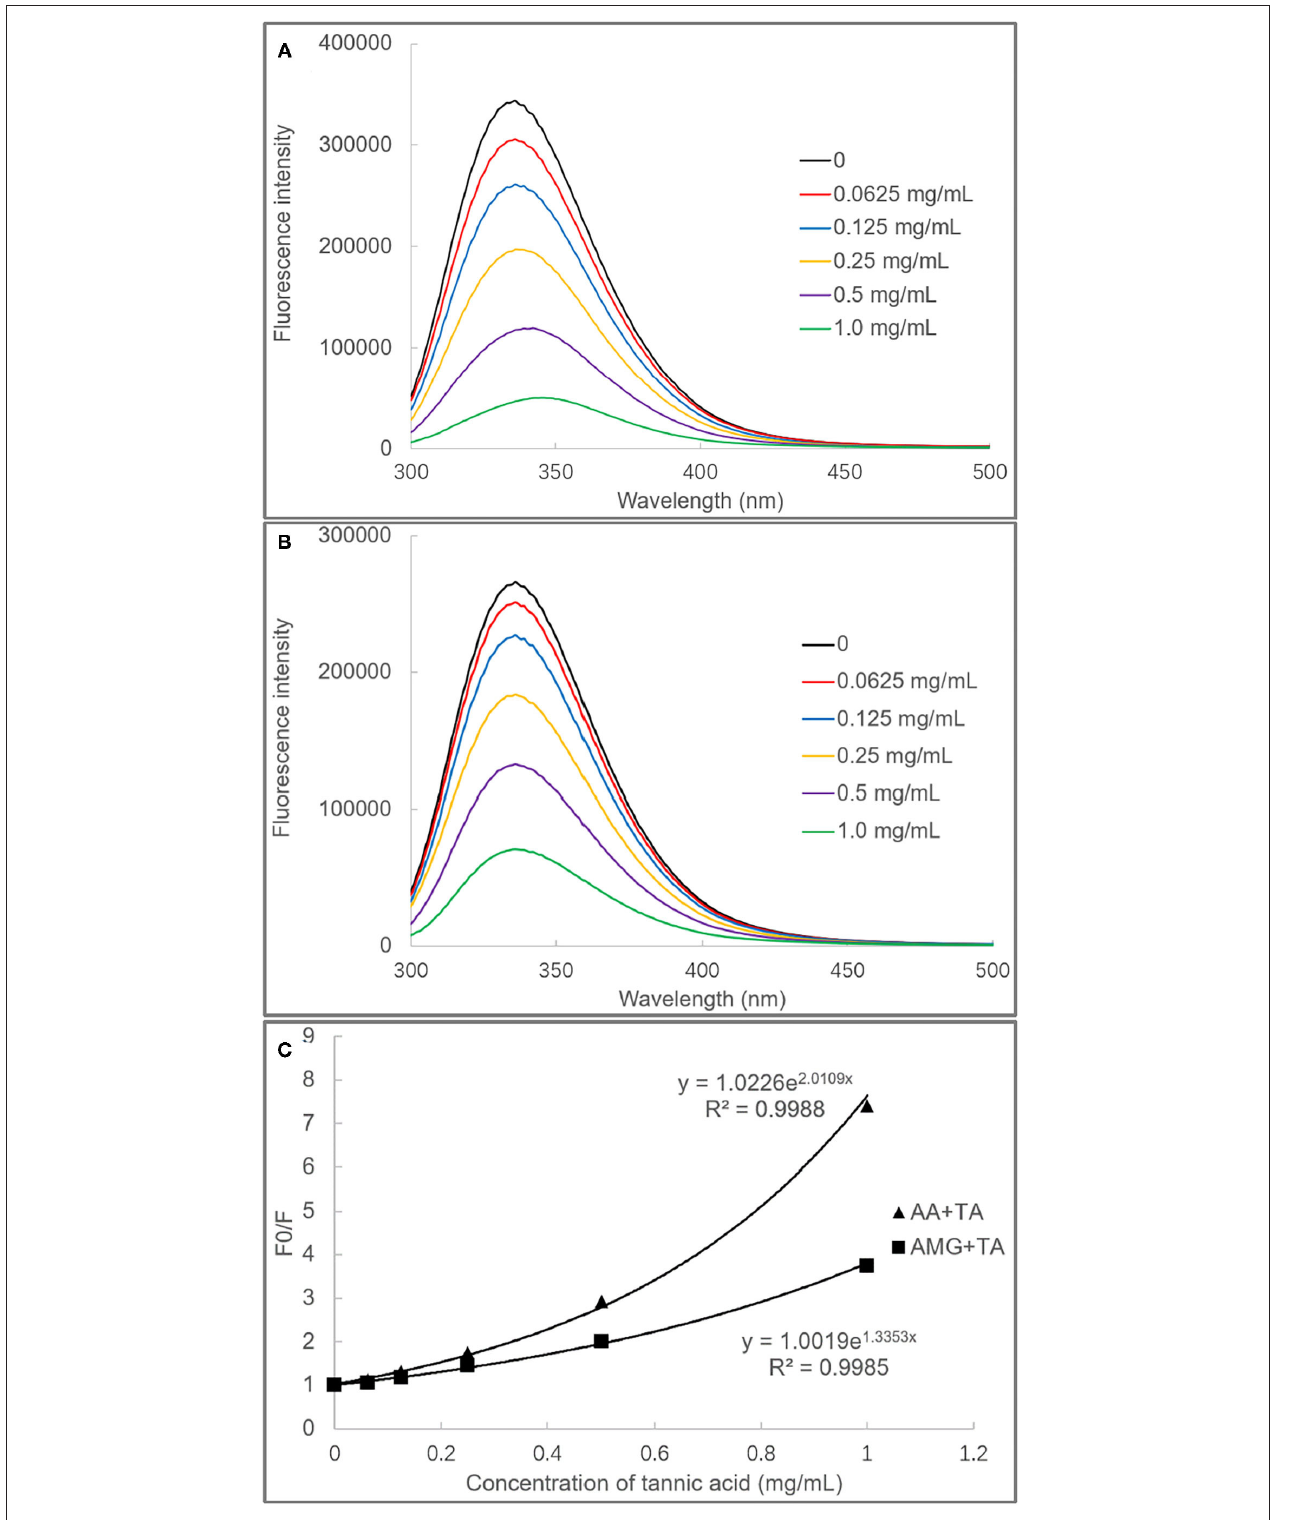
FIGURE 3 | The fluorescence spectra of AA (A) and AMG (B) in the absence and presence of TA, and the fluorescence quenching effects of TA were analyzed by the modified (exponential) form of Stern–Volmer equation (C) .